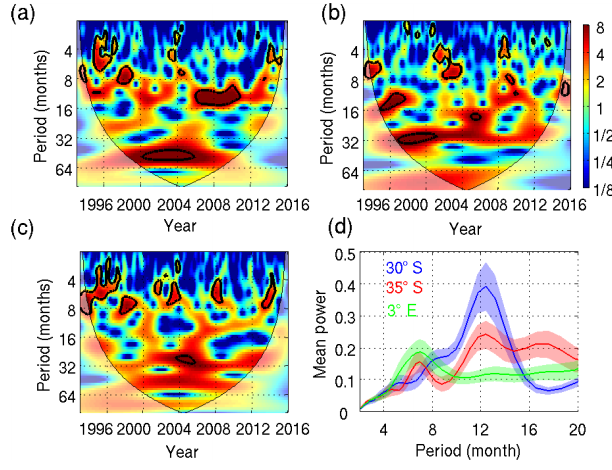
Figure 6. Wavelet spectral density of meridional transports at (a) 30 ◦ S and (b) 35 ◦ S, and (c) zonal transport at 3 ◦ E. (d) Mean wavelet power spectra at 30 ◦ S (blue), 35 ◦ S (red), and 3 ◦ E (green). The black contours are the 95% confidence interval. The values out- side the cone of influence (blurred colors) indicate where the edge errors